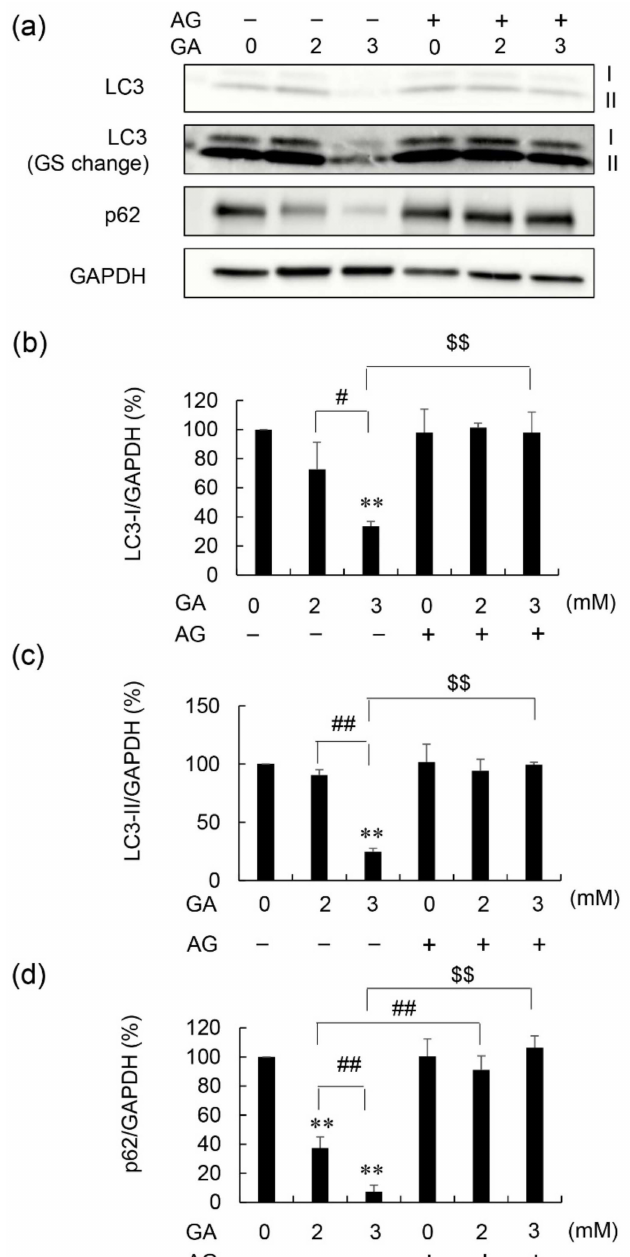
Figure 3. Detection of LC3 and p62 via WB analysis in 1.4E7 cells treated with GA and AG. 1.4E7 cell lysates were loaded onto from 4 to 15% polyacrylamide gradient gels (Ten µ g of proteins per lane). Cells were initially treated with 0 or 16 mM AG for 2 h, followed by 0–3 mM GA for 24 h. This analysis was performed to evaluate cell viability in three independent experiments. ( a ) Proteins on PVDF membranes were targeted with anti-LC3, anti-p62, and anti-GAPDH antibodies. GS: gray scale. Gray scale change: the value of the gray scale was 10,000 in the Fusion FX software. I and II show the LC3-I and -II position. WB was performed in three independent experiments. GAPDH was used as a loading control. ( b ) Protein levels of LC3-I were normalized to those of GAPDH. ( c ) Protein levels of LC3-II were normalized to those of GAPDH. ( d ) Protein levels of p62 were normalized to those of GAPDH. ( b – d ) Data are shown as the mean ± S.D. ( n = 3). p -values were based on Tukey’s test. ** p < 0.01 vs. 0 mM GA without AG. # p < 0.05 vs. 2 mM GA without AG. ## p < 0.01 vs. 2 mM GA without AG. $$ p < 0.01 vs. 3 mM GA without